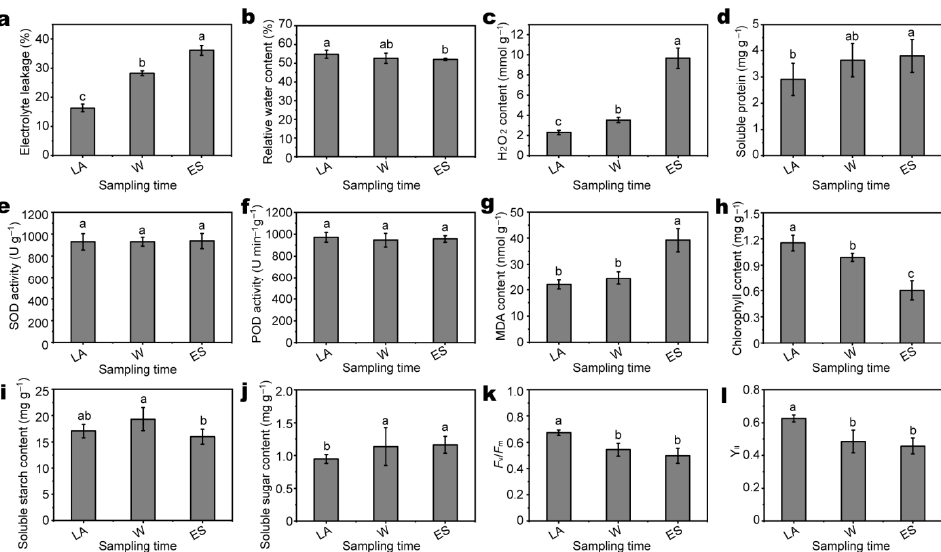
Figure 1. Physiological indicators that were determined in overwintering Cryptomeria fortunei . ( a ) Electrolyte leakage level; ( b ) relative water content; ( c ) hydrogen peroxide (H 2 O 2 ) content; ( d ) soluble protein content; ( e ) superoxide dismutase (SOD) activity; ( f ) peroxidase (POD) activity; ( g ) malondialdehyde (MDA) content; ( h ) chlorophyll content; ( i ) soluble starch content; ( j ) soluble sugar content; ( k ) the maximum quantum yield of photosystem II (PSII) ( Fv/Fm ); ( l ) the effective quantum yield of PSII (Y II ). Sample abbreviations are as follows: ES, early spring; LA, late autumn; and W, winter. Each value in the graph is the mean ± standard deviation (n = 6), and lowercase letters above each bar indicate significant differences ( p < 0.05).